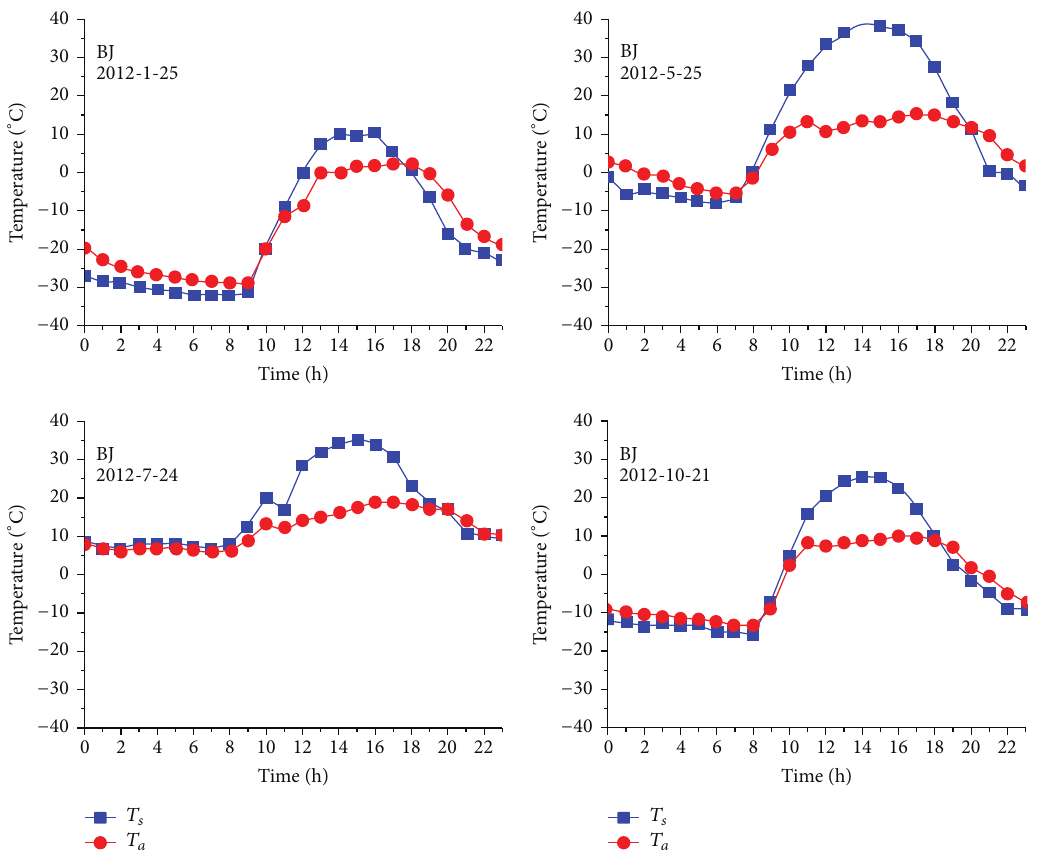
Figure 6: The diurnal variation of land surface temperature ( 𝑇 𝑠 ) and air temperature ( 𝑇 𝑎 ) in typical clear days in different seasons at